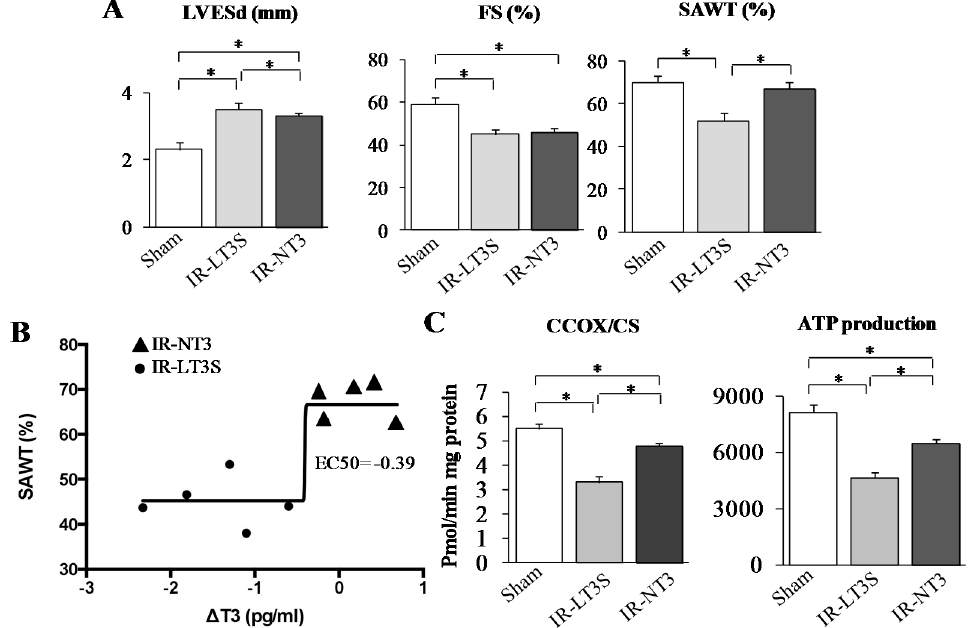
Figure 1. Effect of L-T3S on cardiac functional recovery and mitochondrial activity 72 h post IR. ( A ) LV end systolic diameter (LVESd) ( left panel), fractional shortening (FS) ( medium panel) and systolic anterior wall thickening (SAWT) ( right panel); ( B ) Non linear fitting (sigmoid) relating the ∆ FT3 values (difference between 3 days post IR and basal) to systolic anterior wall thickening (SAWT) in IR-LT3 and IR-NT3; and ( C ) mitochondrial function assessed in the LV area at risk (AAR): citrate synthase (CS) normalized cytochrome c oxidase (CcOx) activity ( left panel) and ATP production ( right panel). Data are expressed as mean ± SE; n = 5 in each group; * p ≤